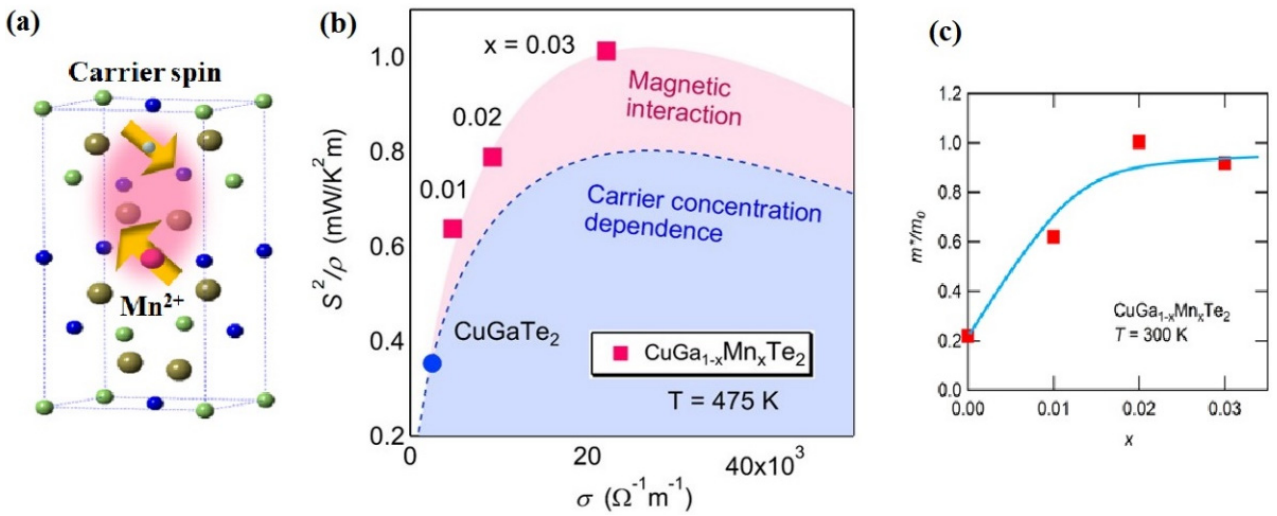
Figure 1. ( a ) Illustration of the paramagnon drag effect, ( b ) estimated power factor enhancement effect via Mn magnetic ion doping in CuGaTe 2 , ( c ) dependence of carrier effective mass versus Mn magnetic ion doping level [31].